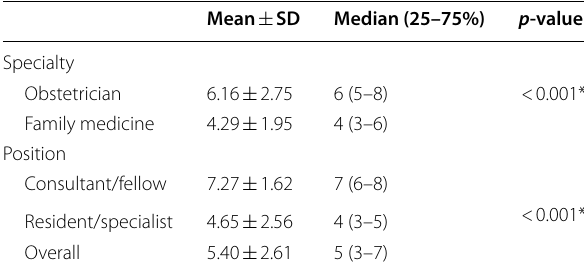
Table 2 Distribution of participants knowledge scores